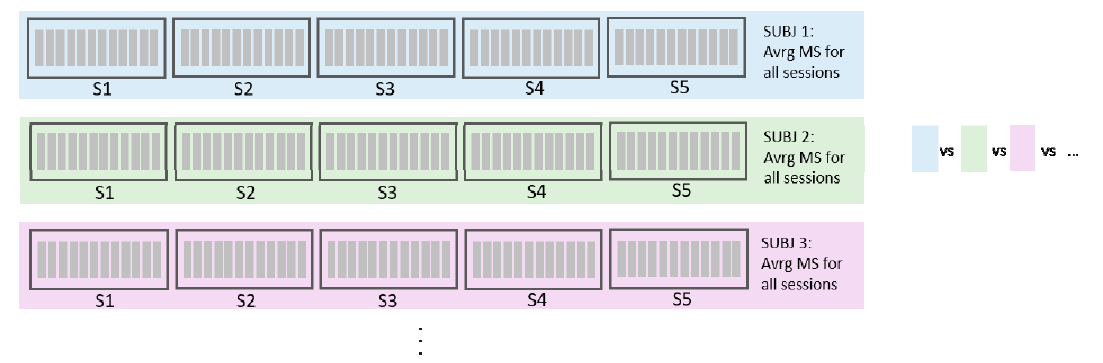
Data structure and analysis steps used for inter-subject analysis: Synergies of